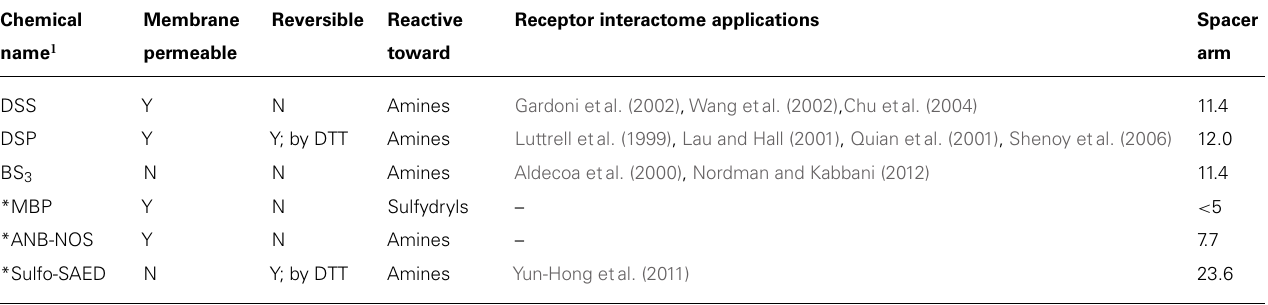
Table 1 |A summary of crosslinkers used in the analysis of receptor protein